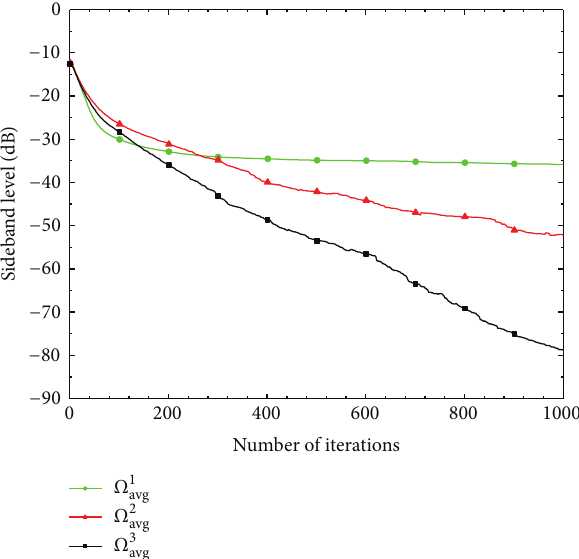
Figure 11: Time-average directivity variation of the three methods for IS— 𝐷 𝑘 represents the time-average directivity and 𝑘 represents the method used, where 𝑘 = 1 : SBL, 𝑘 = 2 : SR, and 𝑘 = 3 : SB.